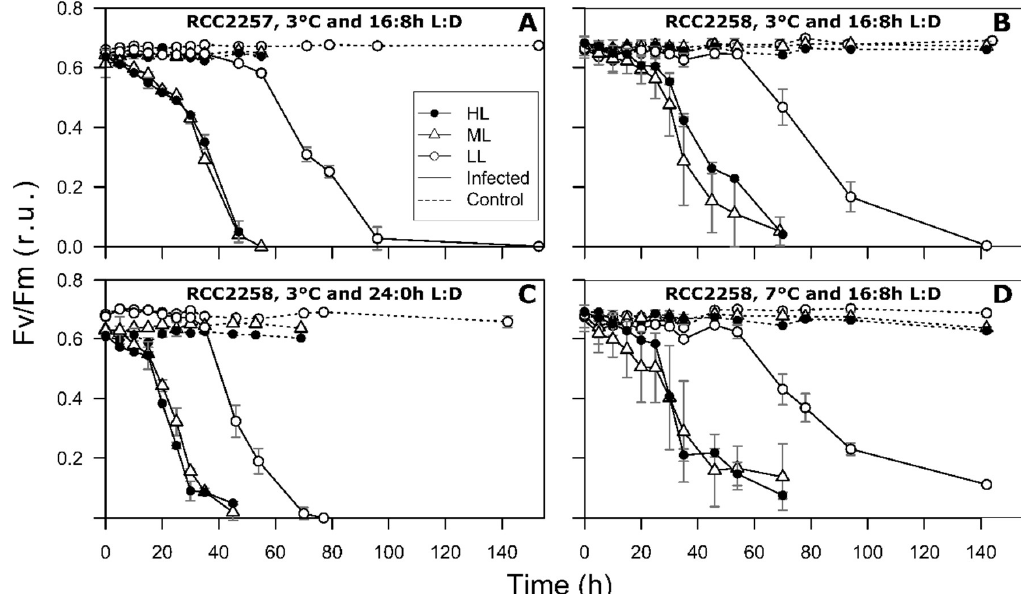
Figure 2. Temporal dynamics of photosynthetic efficiency (Fv/Fm) for non-infected controls (dashed lines) and MpoV-45T infected Micromonas polaris RCC2257 ( A ) and RCC2258 ( B – D ), cultured at 3 °C ( A – C ) and 7 °C ( D ), with a 16:8 h ( A , B , D ) and 24:0 h ( C ) light:dark (L:D) cycle and different light intensities (LL, ML and HL, i.e. respectively, 5, 60, and 160 μmol quanta m -2 s -1 ). LL at 3 °C and 16:8 h L:D cycle and ML at 7 °C and 16:8 h L:D have n = 4, ML at 3 °C and 16:8 h L:D has n = 6, all the other conditions have n = 2. Error bars represent standard deviation and r.u. stands for relative units.